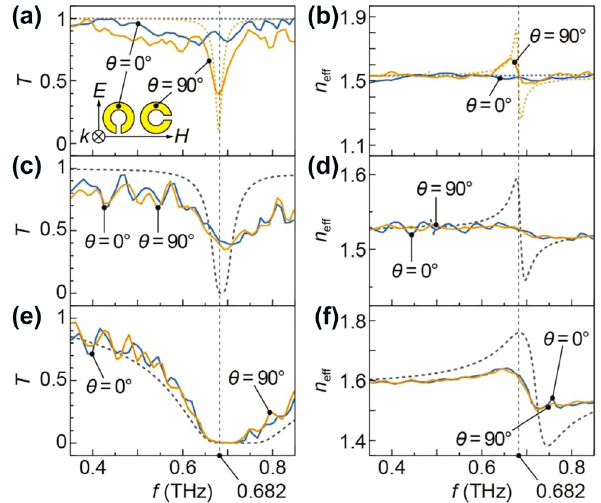
Figure 5: (a) and (b) The transmittance spectra and the effective refractive index of the resin sheet containing SRRs for 200 μ m grains, respectively. The inset shows the de fi nition of the incident polarization angle to the direction of SRRs. (c) and (d) The transmittance spectra and the effective refractive index of the bulk metamaterial using 200 μ m grains. (e) and (f) The transmittance spectra and the effective refractive index of the bulk metamaterial using 100 μ m grains. For all fi gures, dashed lines show the simulation